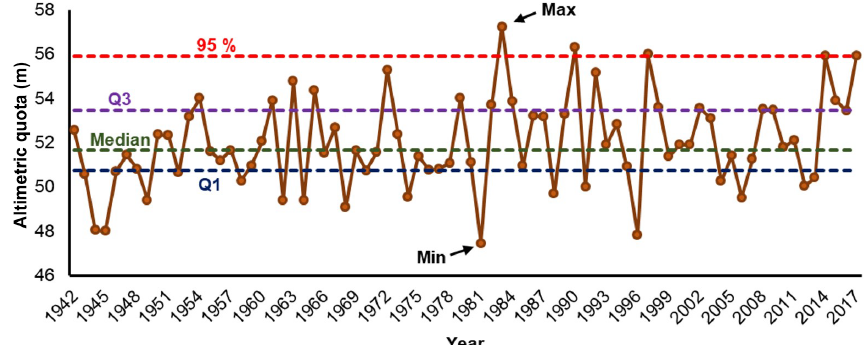
Figure 5. Annual fluviometric maximum level records of the Uruguay River in Itaqui.